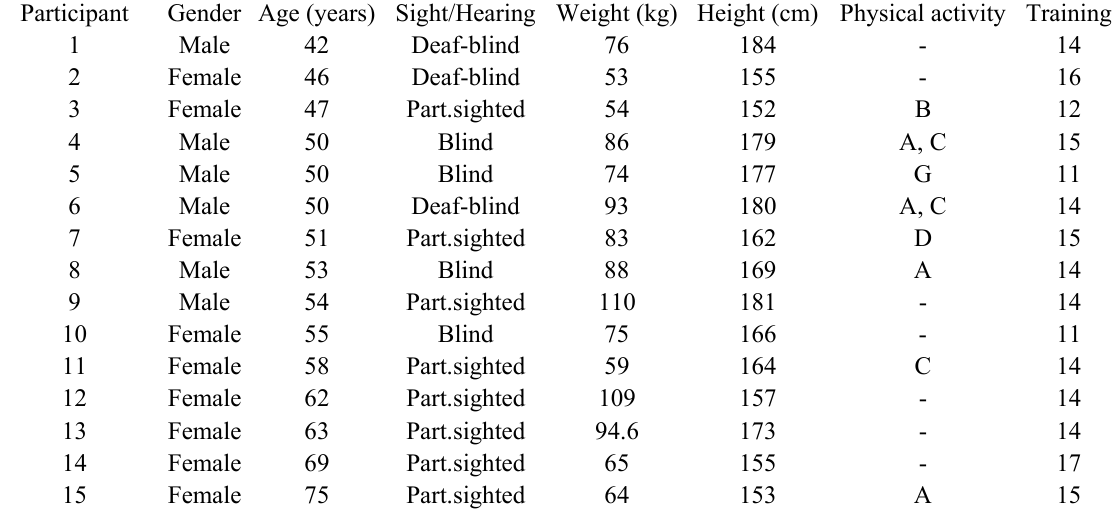
Table 1 Characteristics of Participants in Experimental Group